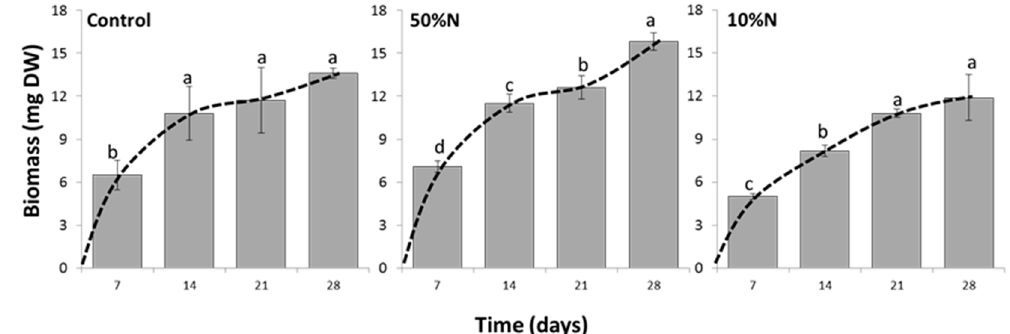
Figure 4. Time course of the growth in Chlorosarcinopsis PY02 under different nitrogen concentrations. Control = TAP with replete nitrogen concentration; 10% N = TAP with 10-fold nitrogen decrease; 50% N = TAP with 2-fold nitrogen decrease. Data was analysed by one-way ANOVA, carried out by a post-hoc Duncan’s test (n = 3, P < 0.05). Values are the mean from measurements of three individual samples, with the lowercase letters indicating statistical difference at P < 0.05 within each graph. Table 1. Effects of nitrogen deprivation on algal growth, biomass and canthaxanthin content at 28 days. Initial N Conc. 1